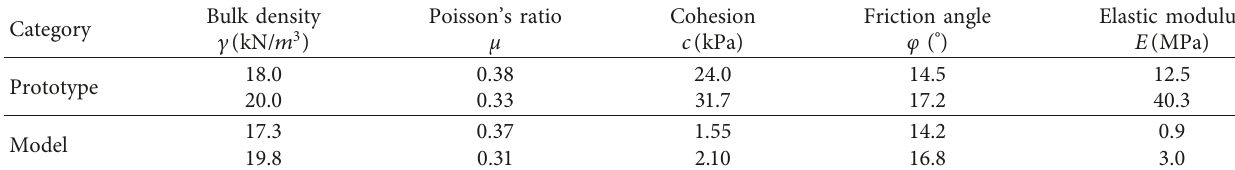
Table 2: Soil physical parameters.